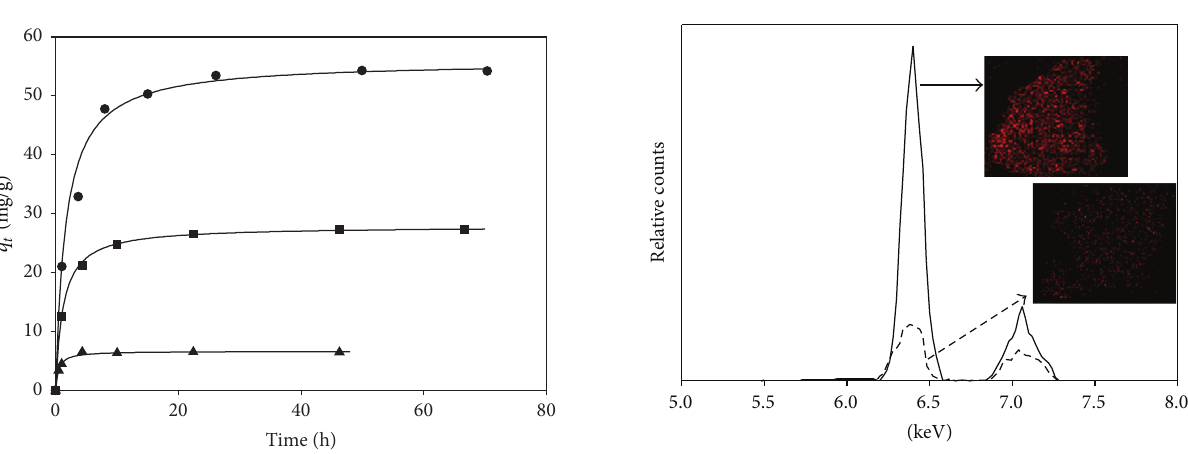
Figure 3: Adsorption kinetics of iron on zeolite at several values of iron concentration: filled circles 1000 mg/L, filled squares 500 mg/L, and filled triangles 100 mg/L. Lines indicate the simulated pseudo- second-order kinetic model.